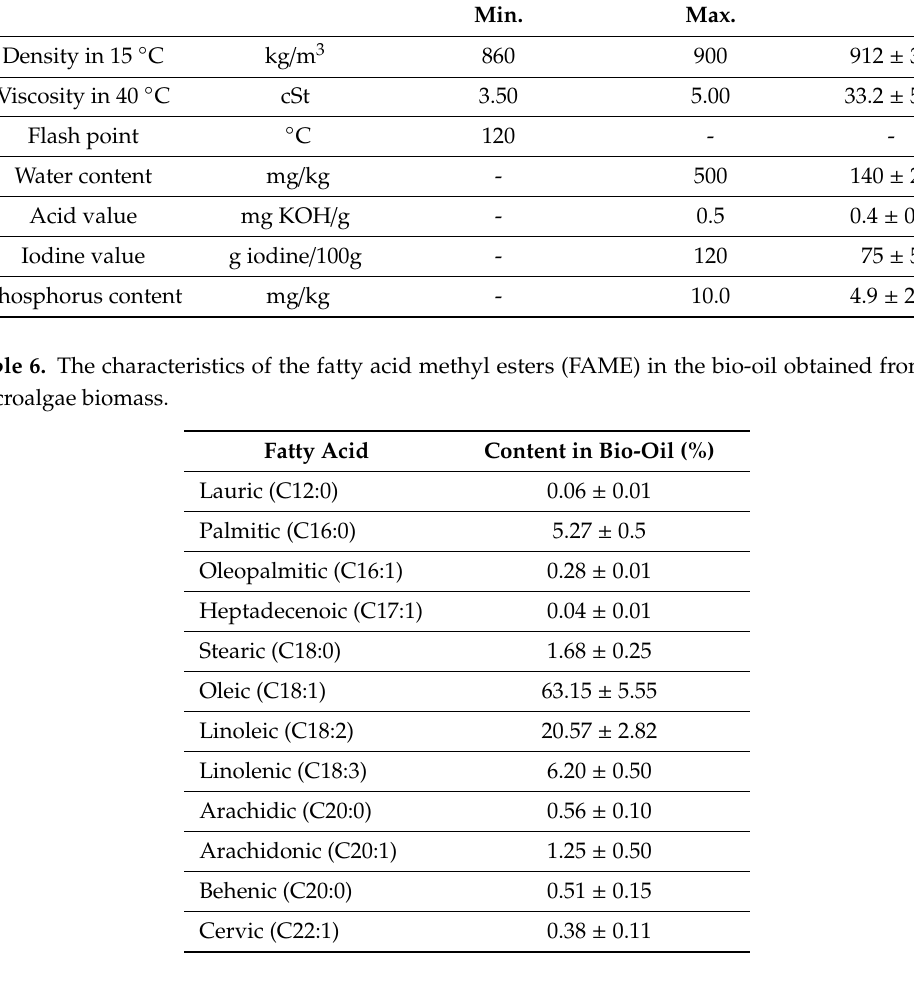
Table 7. Characteristics of the e ffl uent from the UASB